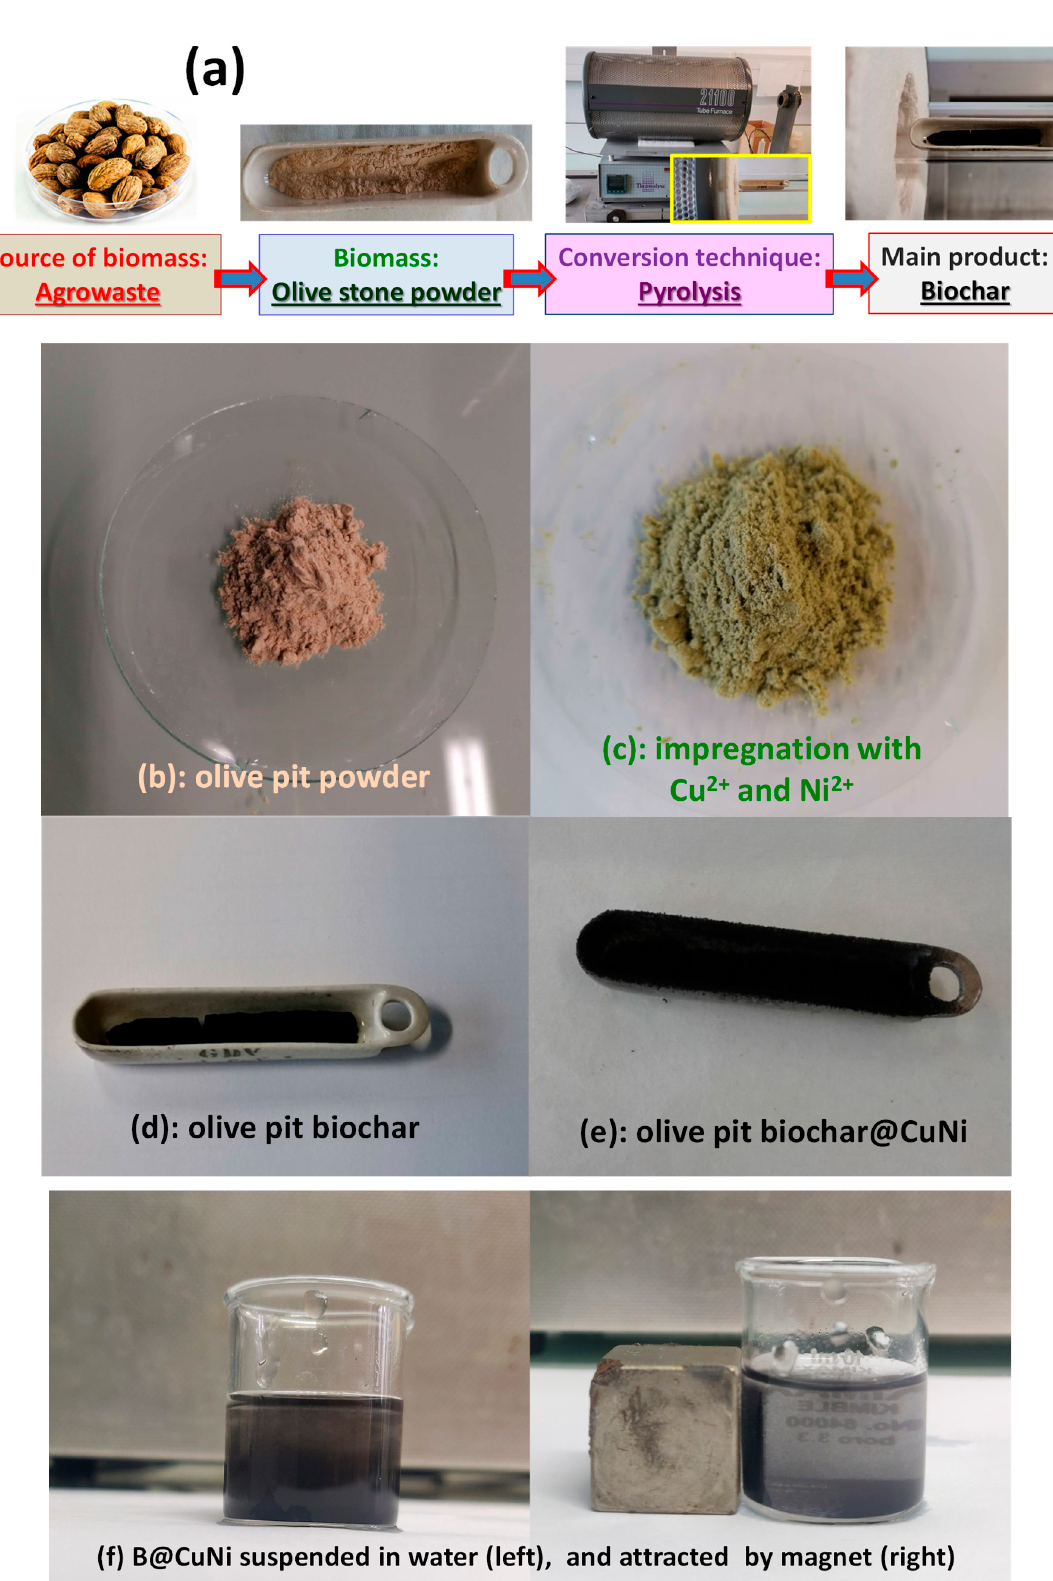
Figure 1. ( a ) Upper panel showing route for making biochar from olive pit biochar. Middle panel shows digital photographs of ( b ) olive pit powder, ( c ) olive pit powder after impregnation into copper and nickel nitrates, ( d ) the olive pit biochar, and ( e ) CuNi-decorated biochar obtained by direct pyrolysis of powder shown in ( c ). Lower panel: ( f ) digital pictures showing suspension of B@CuNi before ( left ) and after attraction by a magnet ( right ).